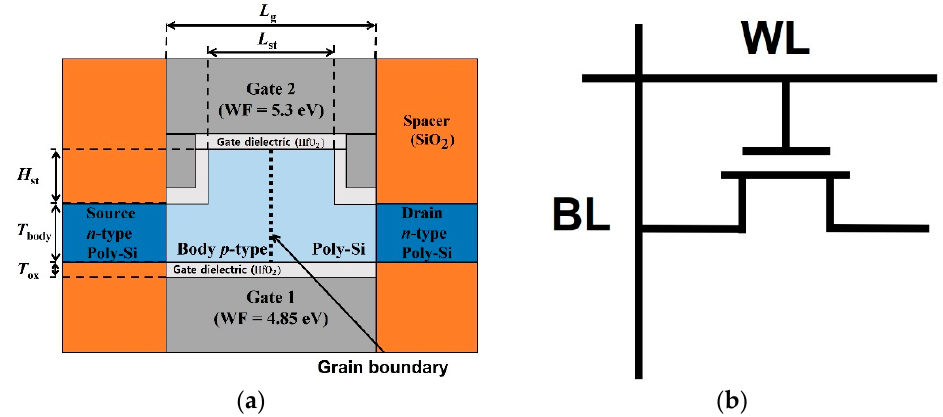
Figure 1. ( a ) Cross-sectional view of the proposed poly-Si dual-gate MOSFET based 1T-DRAM with a fin-shaped structure. ( b ) Simplified circuit diagram of 1T-DRAM. a fin-shaped structure. ( b ) Simplified circuit diagram of